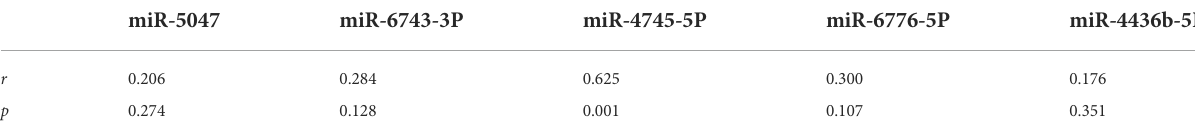
TABLE 9 Correlation between FX and corresponding